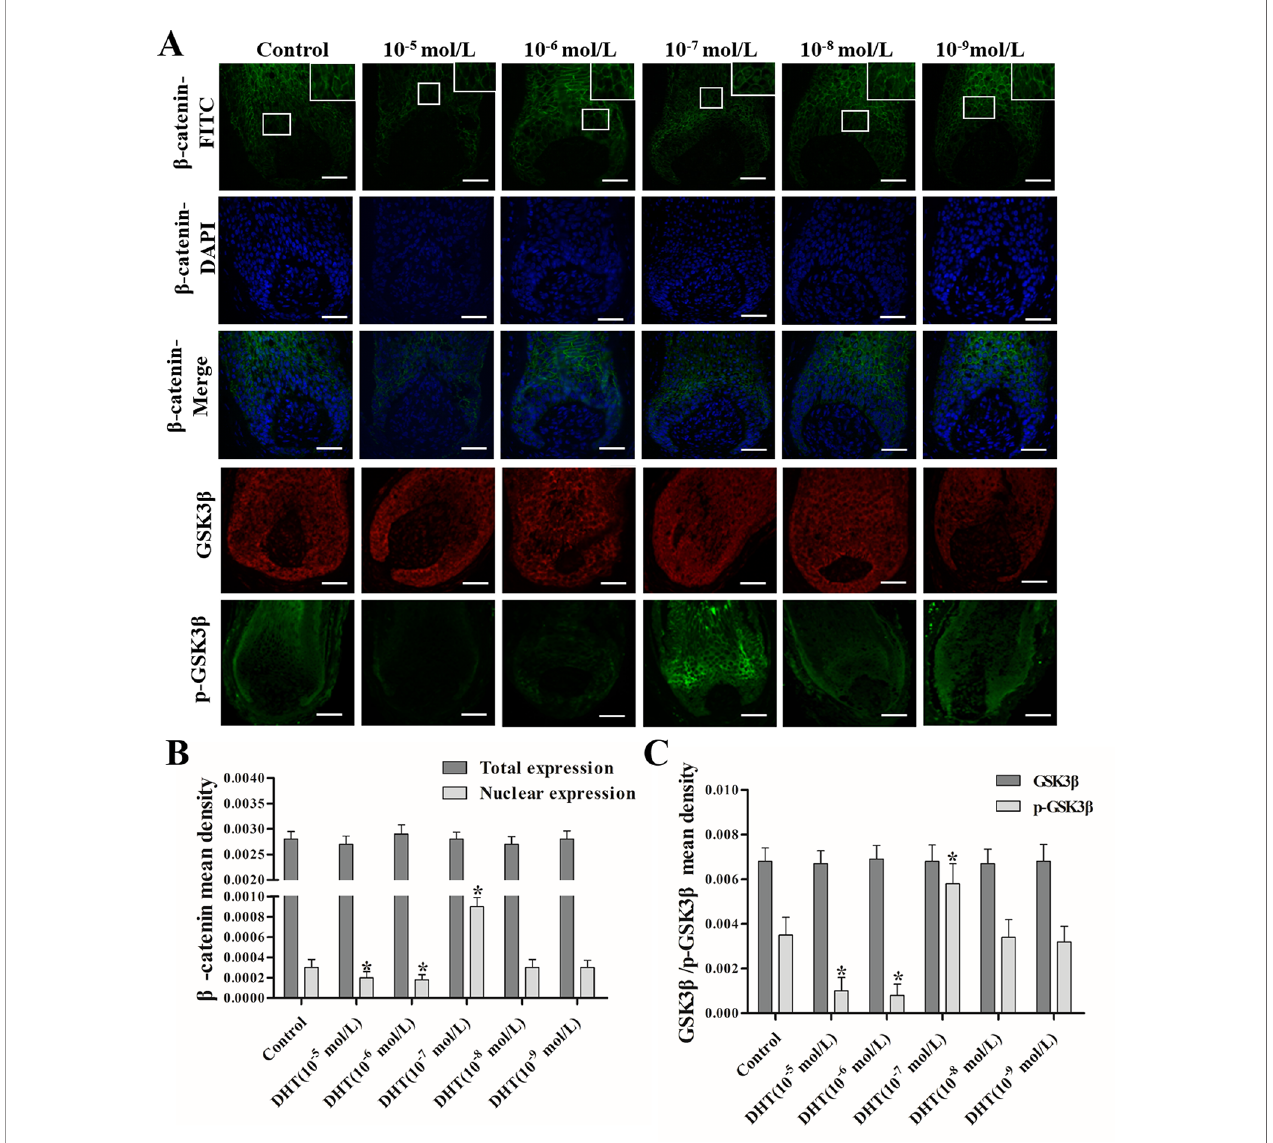
FIGURE 4 | Effects of different concentrations of dihydrotestosterone (DHT) on the expression of b -catenin, GSK3 b , and p-GSK3 b (ser9) in human HFs. The hair follicles (HFs) were fi xed and labeled with anti- b -catenin, anti-GSK3 b , and anti-p-GSK3 b (ser9) primary antibodies, followed by incubation with fl uorescent secondary antibodies. (A) The HFs were visualized: green, b -catenin and p-GSK3 b (ser9); red, GSK3 b (magni fi cation: 200× and 400×). (B , C) The mean fl uorescence intensity of b -catenin, GSK3 b , and p-GSK3 b (ser9) in the matrix area. The data are presented as the mean ± SD (n = 6). Each bar represents the mean of three independent experiments performed in triplicate. Compared with the control group, * P < 0.05. Scale bar 50 m m